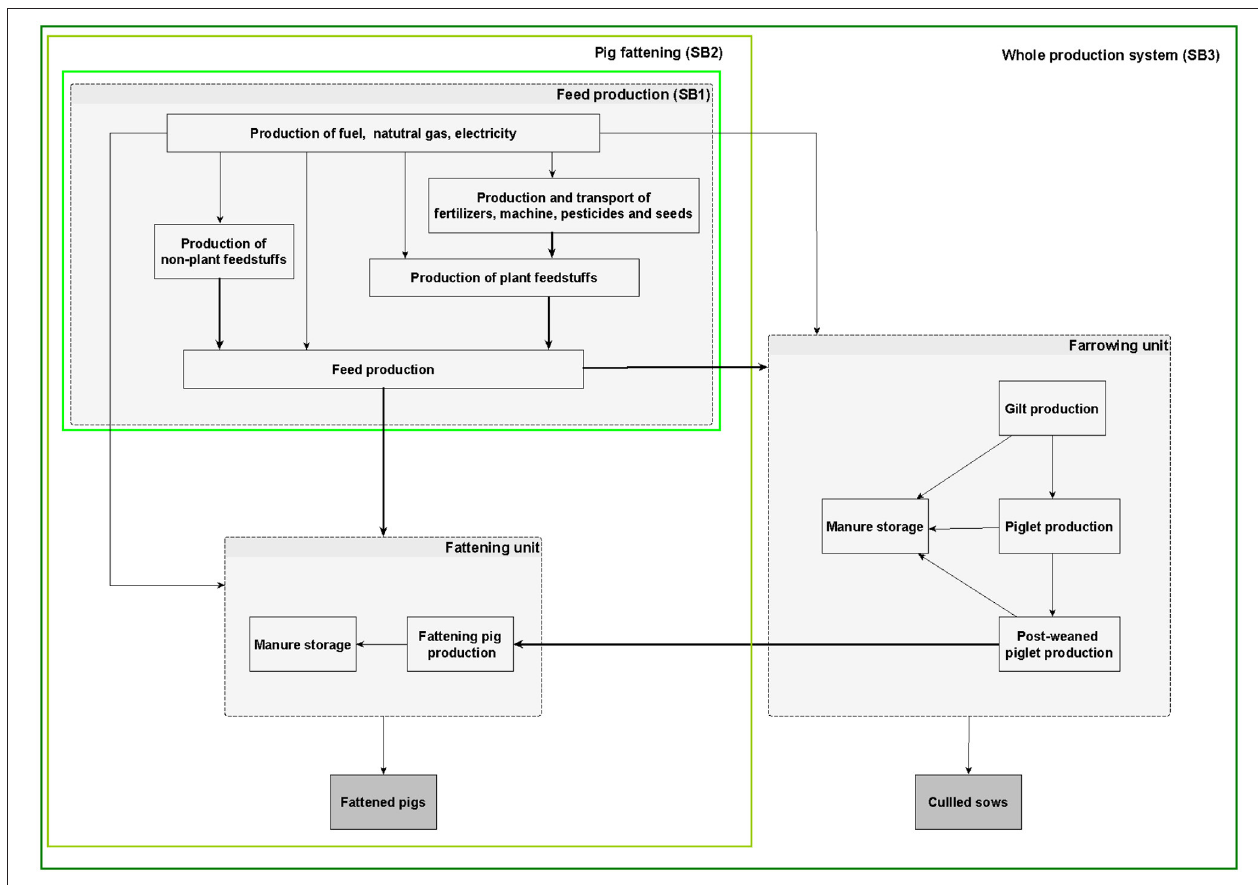
FIGURE 1 | Description of the three system boundaries (SB) considered in this